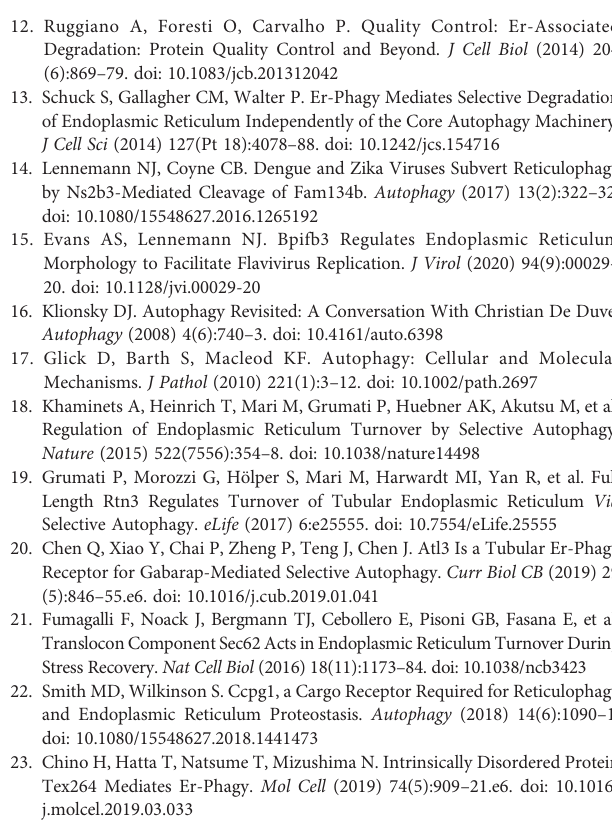
Supplementary Table 2 | Primers used for